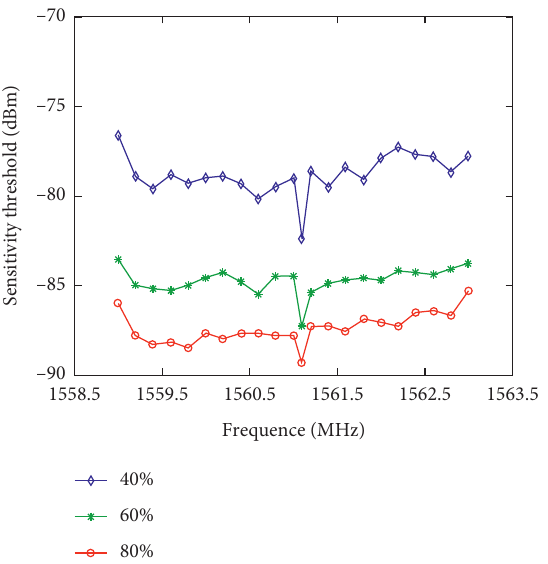
Figure 11: The electromagnetic sensitivity curve of the receiver when f PRF � 1MHz.